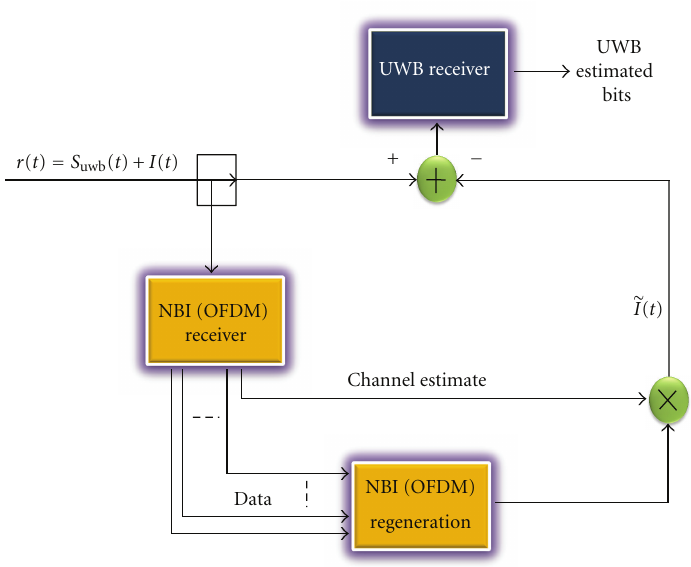
Figure 1: A simplified schematic model for the proposed canceller scheme.